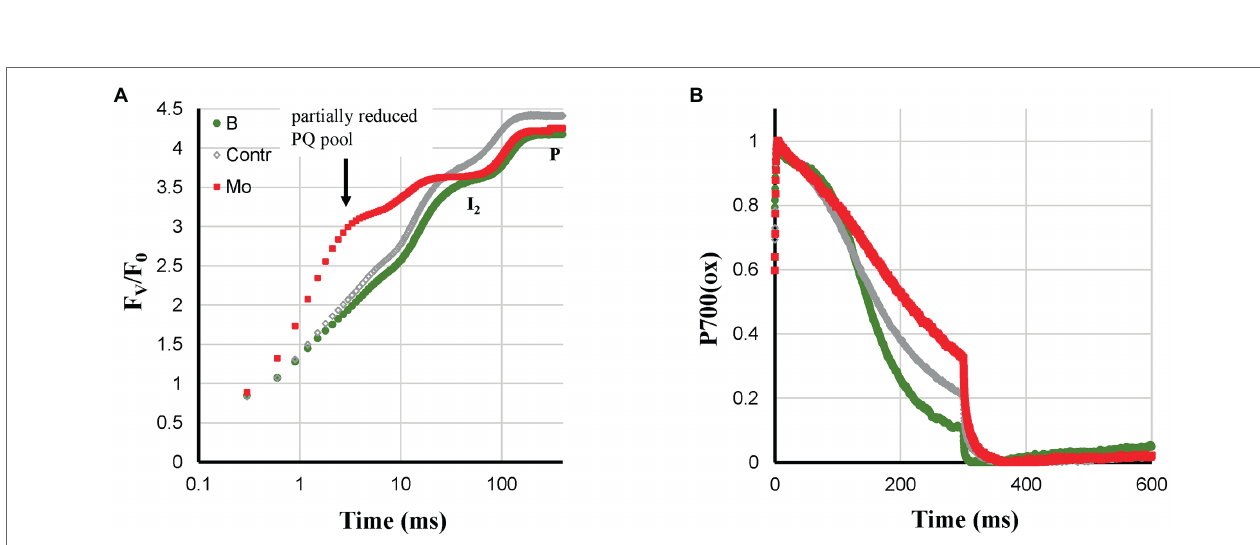
FIGURE 6 | Effect of B- and Mo-deficiencies applied to hydroponically grown sunflower plants on the polyphasic rise (A) and P700 + (B) kinetics, respectively. The transients are averages of four independent